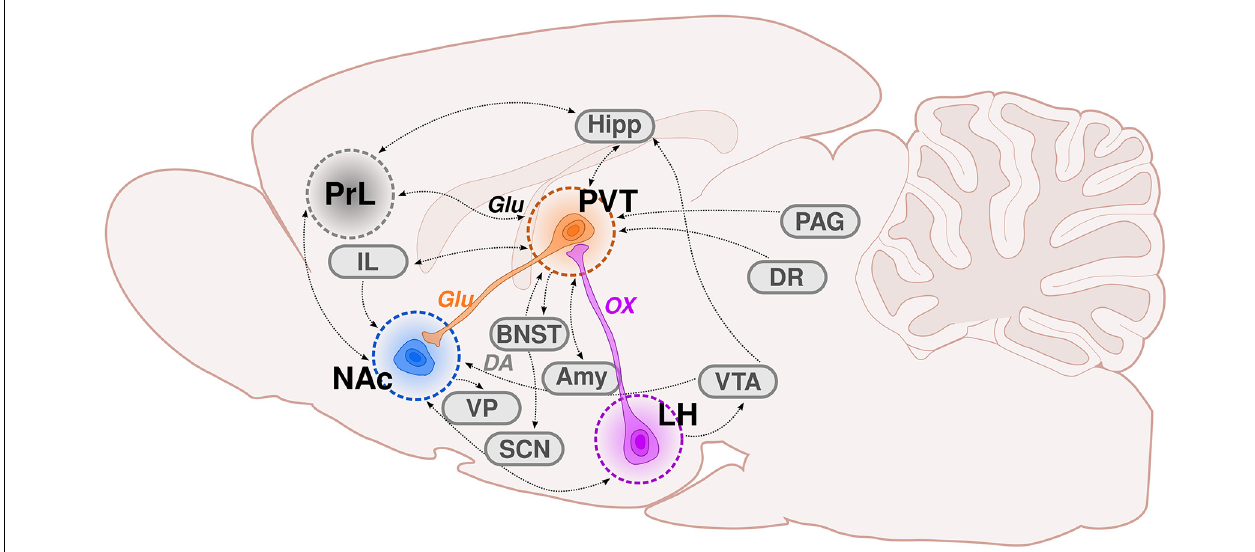
FIGURE 1 | The PVT as a critical node of the hypothalamic-thalamic-striatal circuit. This graphic illustrates the afferents and efferents associated with the paraventricular nucleus of the thalamus (PVT), with an emphasis on the hypothalamic-thalamic-striatal circuit. The purple neuron represents orexinergic (OX) innervation from the lateral hypothalamus (LH)-PVT. The orange neuron is illustrating glutamatergic (Glu) innervation from the PVT-nucleus accumbens (NAc). The blue circle depicts the NAc, which receives substantial innervation from the PVT. The gray circle represents the anatomical location of the prelimbic cortex (PrL), which sends dense glutamatergic innervation to the PVT. The dotted black lines throughout the schematic depict neuronal connections, some of which are reciprocal (double arrow). Amy, amygdala; BNST, bed nucleus of the stria terminalis; DR, dorsal raphe; Hipp, hippocampus; IL, infralimbic cortex; LH, lateral hypothalamus; NAc, nucleus accumbens; PAG, periaqueductal gray; PrL, prelimbic cortex; PVT, paraventricular thalamic nucleus; SCN, suprachiasmatic nucleus; VP, ventral pallidum; VTA, ventral tegmental area; DA, dopamine; Glu, glutamate; OX,